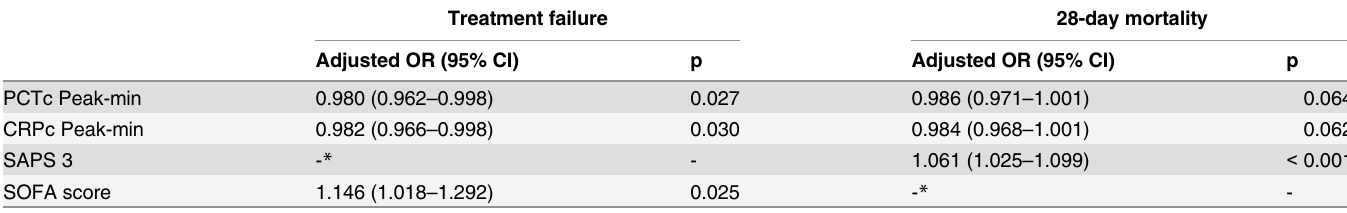
Table 4. Multiple logistic analysis for biochemical markers in predicting treatment failure and 28-day mortality.